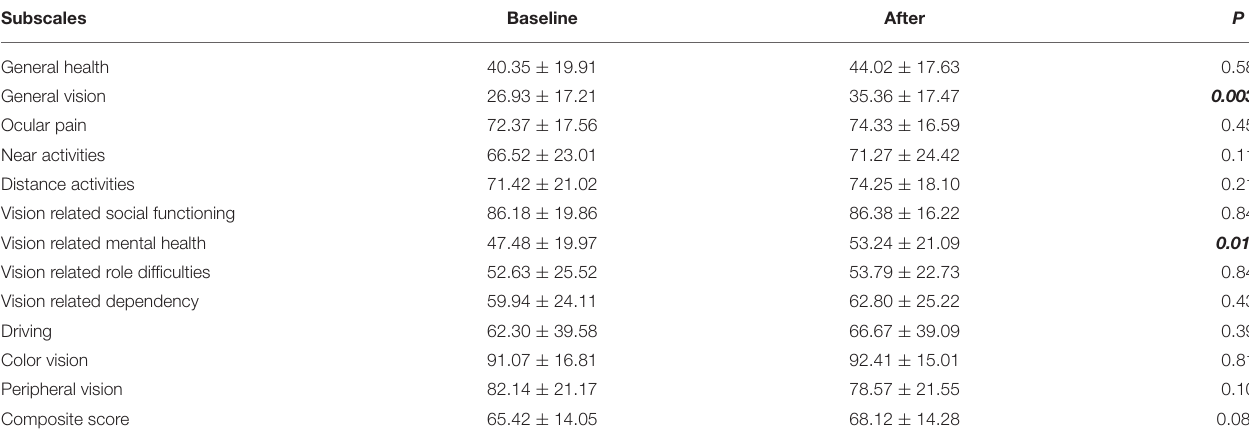
TABLE 3 | Subjective QoL score by VFQ25 before and after anti-VEGF treatment.